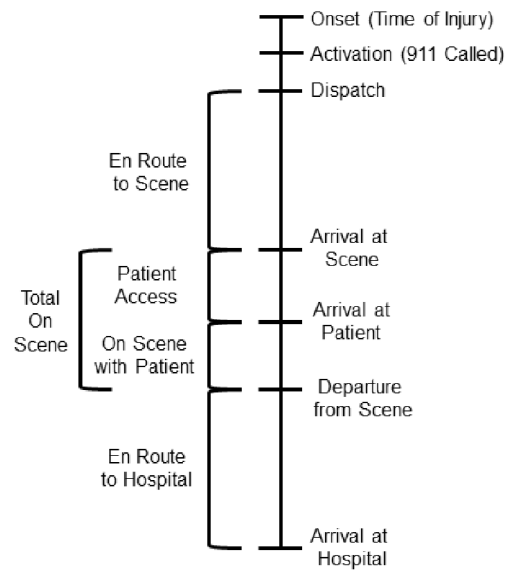
Figure 2. Timeline of Emergency Medical Services (EMS) documented time points (right side of the timeline) with the calculated time intervals utilized in the study (left side of the timeline).